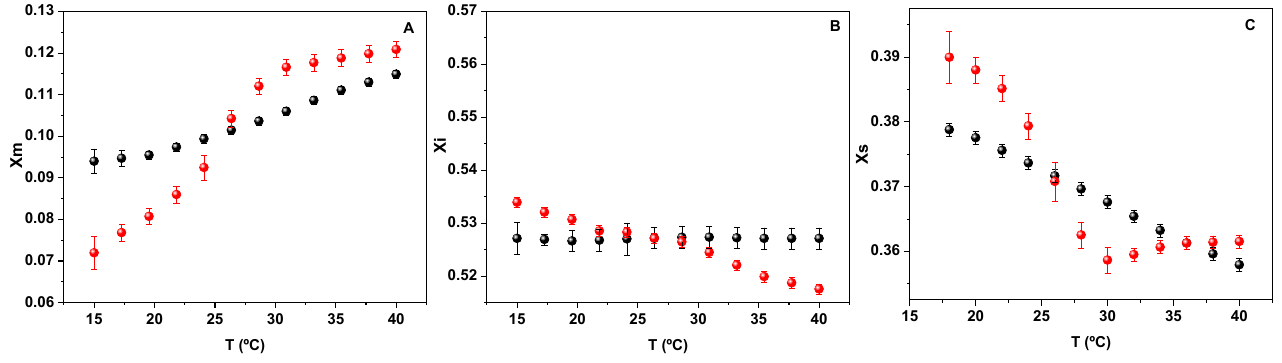
Figure 4. Molar fraction of water monomer ( A ) water bound with less than four H bonds ( B ) and tetracoordinated water molecules ( C ) as a function of temperature. Black symbols correspond to pure water, red symbols correspond to water in the presence of lipids.